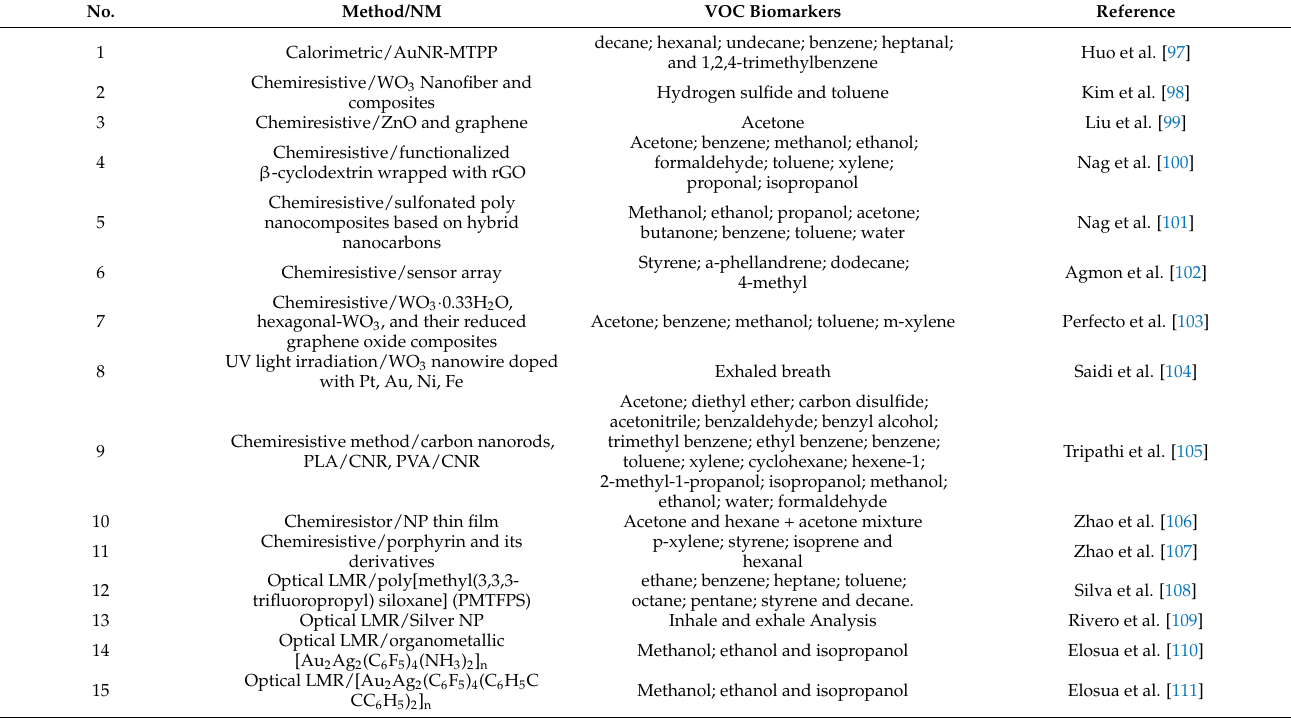
Table 4. Various biomarkers and methodology/NM used towards lung cancer exhaled breath